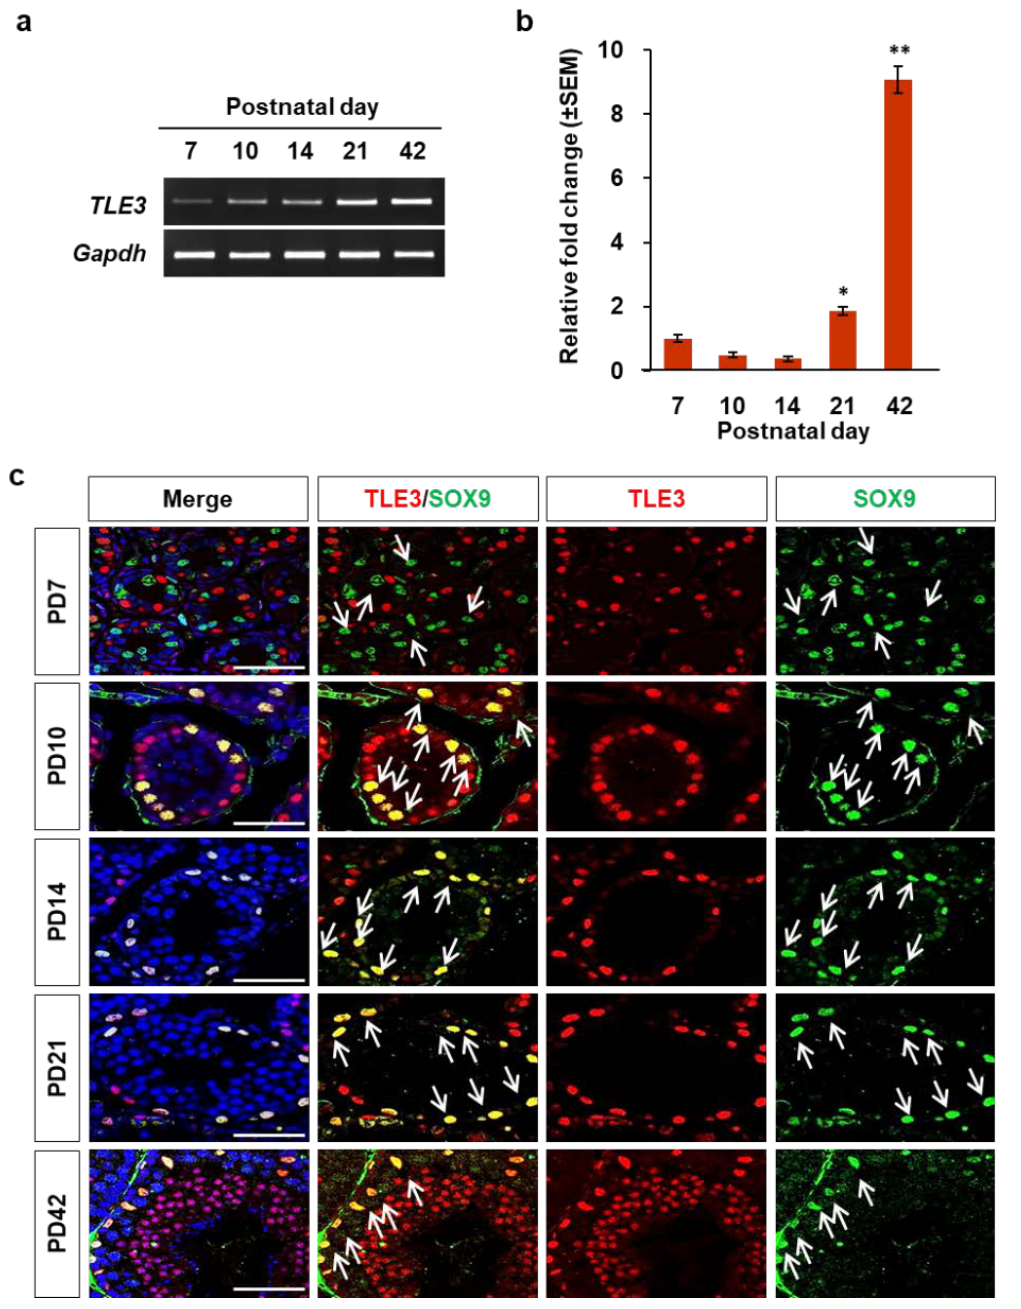
Figure 2. Expression of TLE3 during development of the seminiferous tubule in the testes. The mRNA was isolated from the testes of PD7, PD10, PD14, PD21, and PD42 mice. ( a , b ) RT-PCR and qRT-PCR analysis of TLE3 transcript in the testes of PD7, PD10, PD14, PD21, and PD42 mice. TLE3 expression levels were normalized with Gapdh mRNA. Data are represented as mean ± SEM. The Student t -test was applied to calculate p -value. *p < 0.05, **p < 0.01. ( c ) Expression of TLE3 and SOX9 during postnatal testicular development. Nuclei were stained by DAPI. White arrow indicates Sertoli cells. Scale bar represents 50 µ